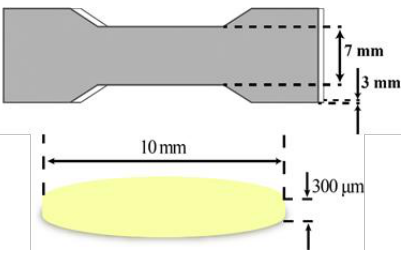
Figure 1. The dimensions of specimen for mechanical tests and oral film samples.